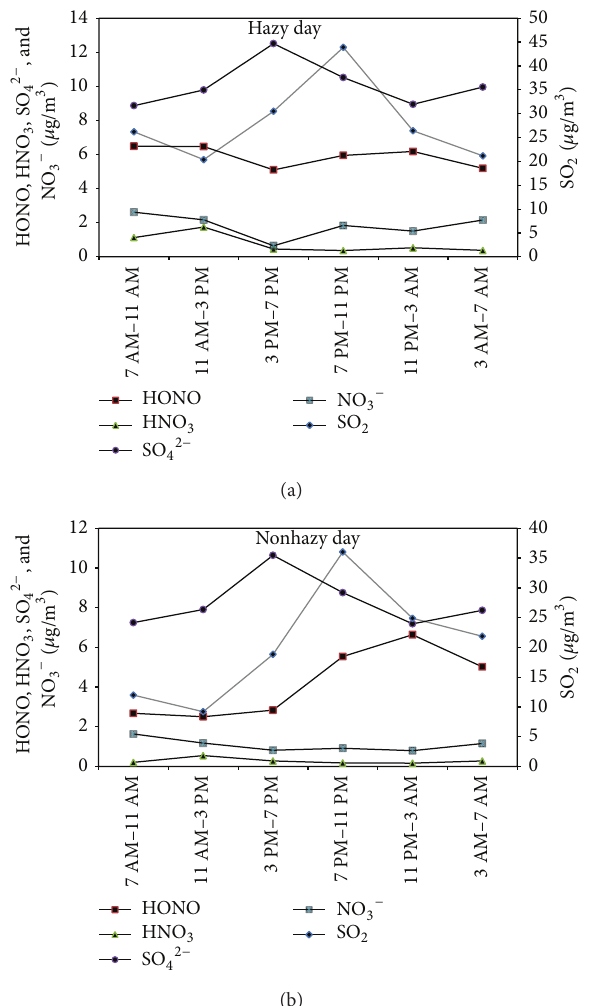
Figure 3: Diurnal variations of SO 2 , HONO, HNO 3 , SO 42− , and NO 3− during (a) hazy day and (b) nonhazy day.